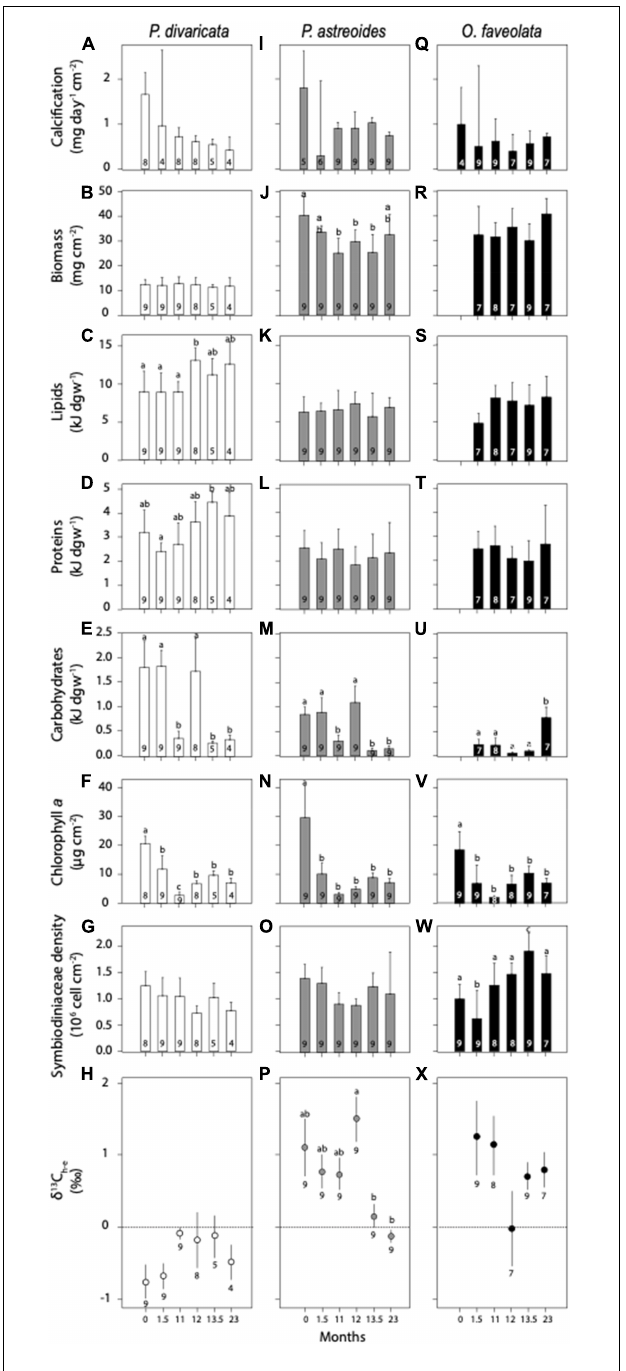
FIGURE 4 | Average ( ± 1 SE) calcification, biomass, lipids, proteins, carbohydrates, chlorophyll a (Chl a ), Symbiodiniaceae density, and δ 13 C h - e of (A–H) Porites divaricata (white), (I–P) Porites astreoides (gray), (Q–X) Orbicella faveolata (black) at each time point (0 month = July 2009, 1.5 months = September 2009, 11 months = June 2010, 12 months = July 2010, 13.5 months = September 2010, and 23 months = June 2010). Averages that do not significantly differ from each other share similar letters or no letters. All Kruskal-Wallis, ANOVA, and Tukey post hoc results in Supplementary Tables 3 , 4 . Sample sizes are represented within each bar and below δ 13 C h - e